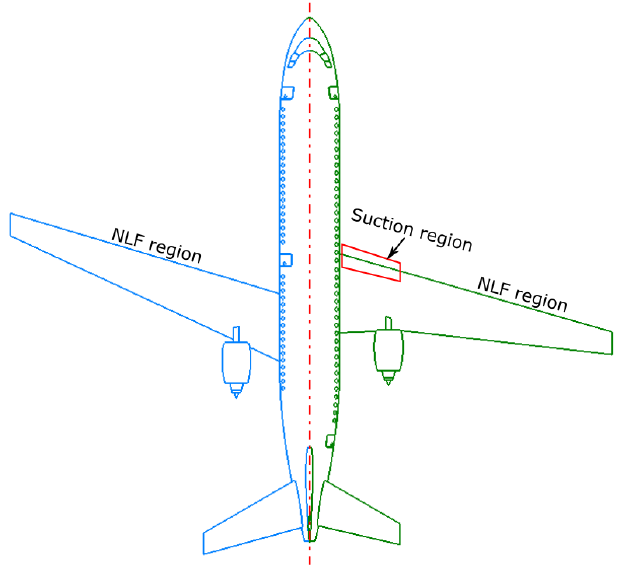
Figure 14. Comparison between two aircraft planforms.